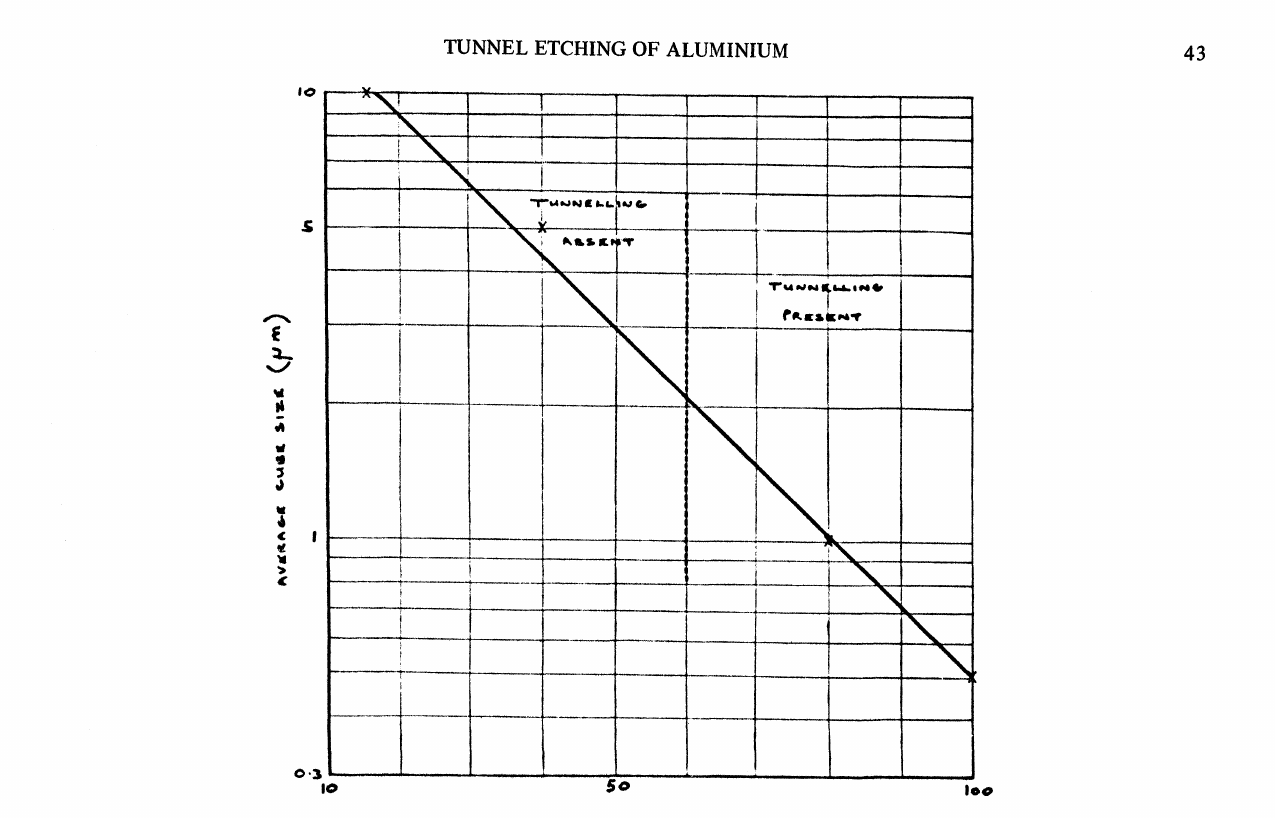
FIGURE 12 Variation of average cube size with temperature (3.42M sodium chloride, 0.6 A crn 24 coulombs cm -2 ).